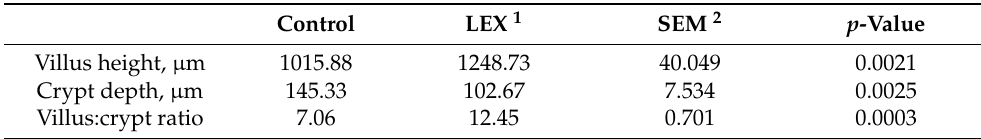
Table 5. Effect of the dietary supplementation of LEX to low-energy diets on the jejunal morphology of broilers in each experimental group.